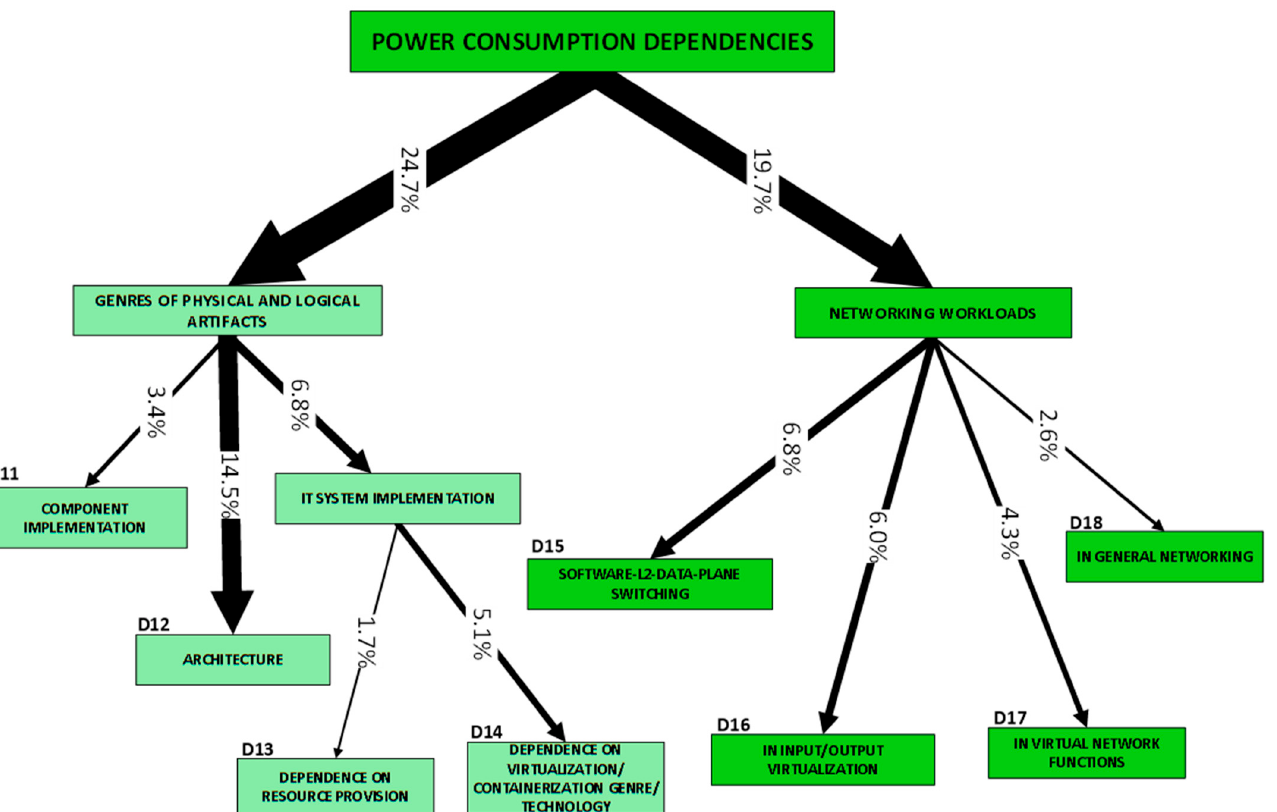
Figure 5. A taxonomy of power dependencies, with frequency of occurrence shown in line thickness and as a percentage.